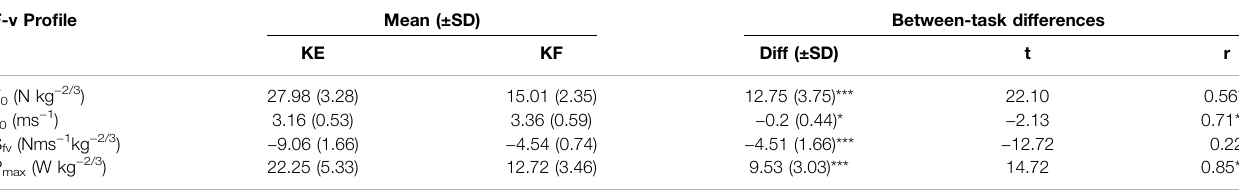
TABLE 2 | Differences between KE and KF F-v pro fi les. F-v Pro fi